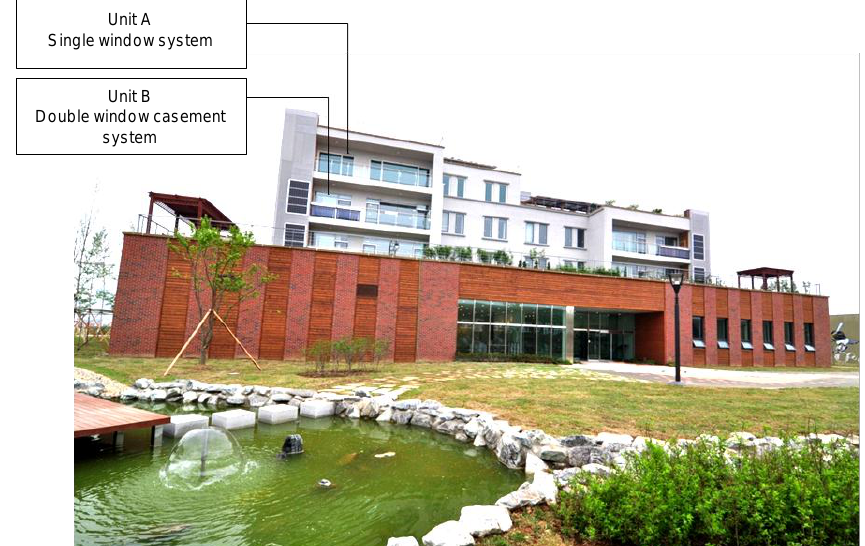
Figure 5. Target building.